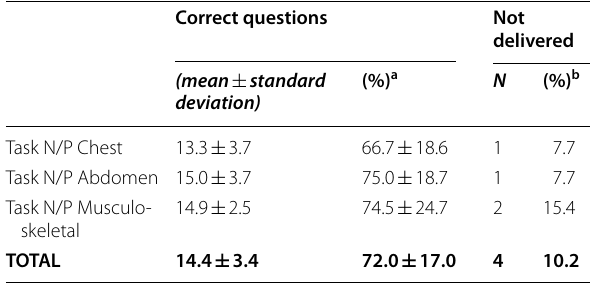
Table 3 Correct questions in the "normal or pathological" tasks during the game, together with the number of tests and tasks not